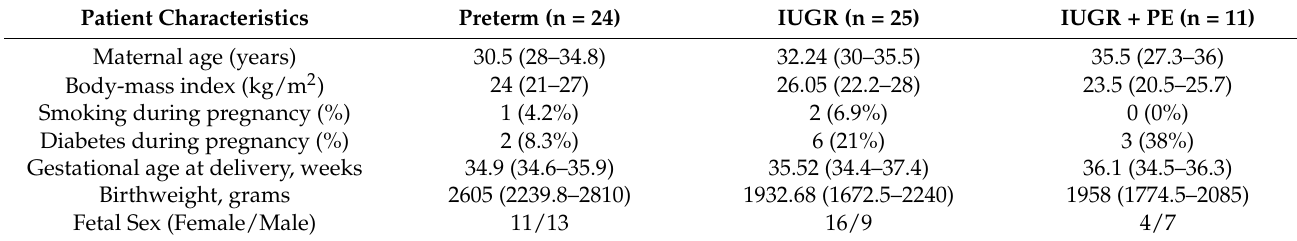
Table 2. Clinical characteristics of >34 Week Patient